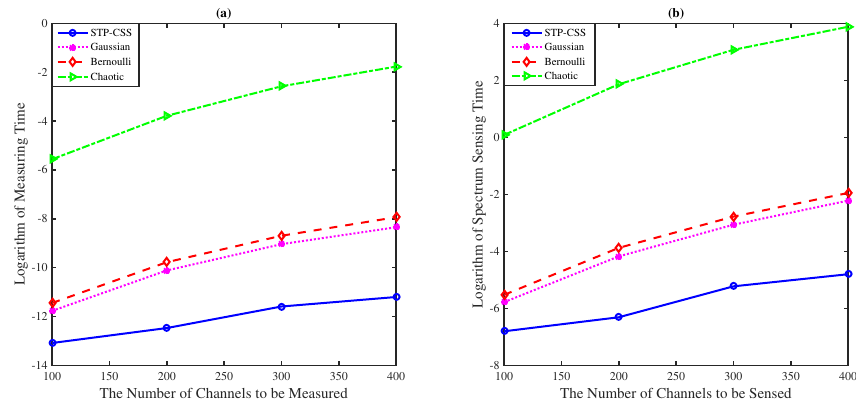
Figure 9. The comparisons of time costs on the measurement process and the whole spectrum sensing process. The numbers of the channels were set to 100, 200, 300, and 400: ( a ) The logarithm of the measurement time. ( b ) The logarithm of the spectrum sensing